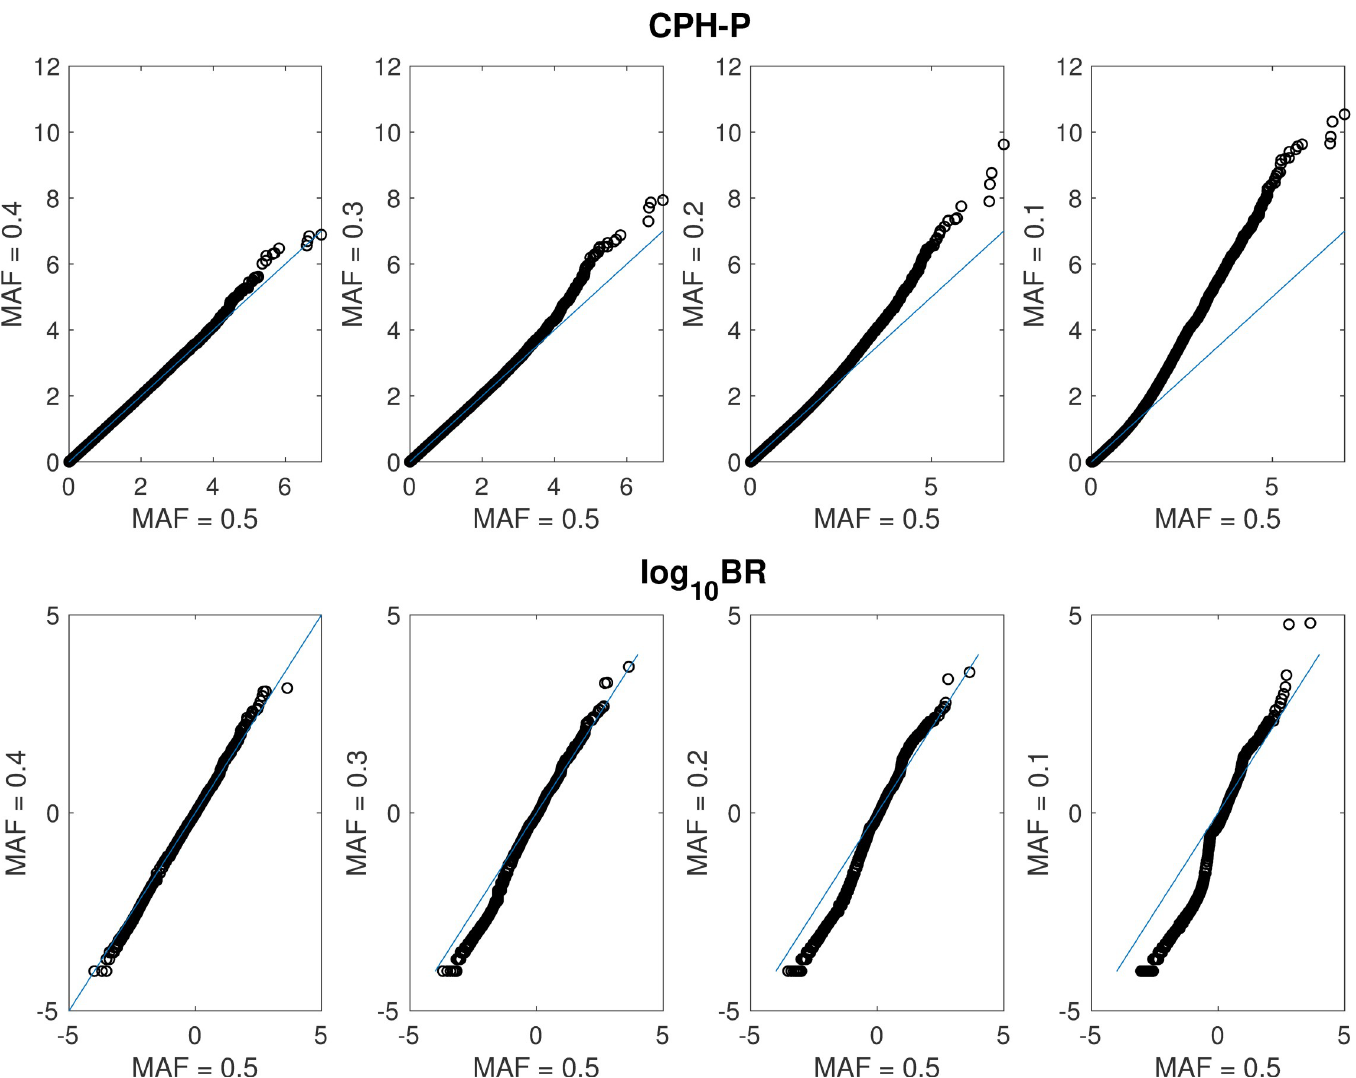
Fig 3. Effects of decreasing minor allele frequency under H 0 . Shown here are QQ plots comparing sampling distributions (N = 400) under H 0 for minor allele frequency (MAF) = 0.4, 0.3, 0.2, 0.1 compared to the corresponding behavior with MAF = 0.5, for CPH-P and log 10